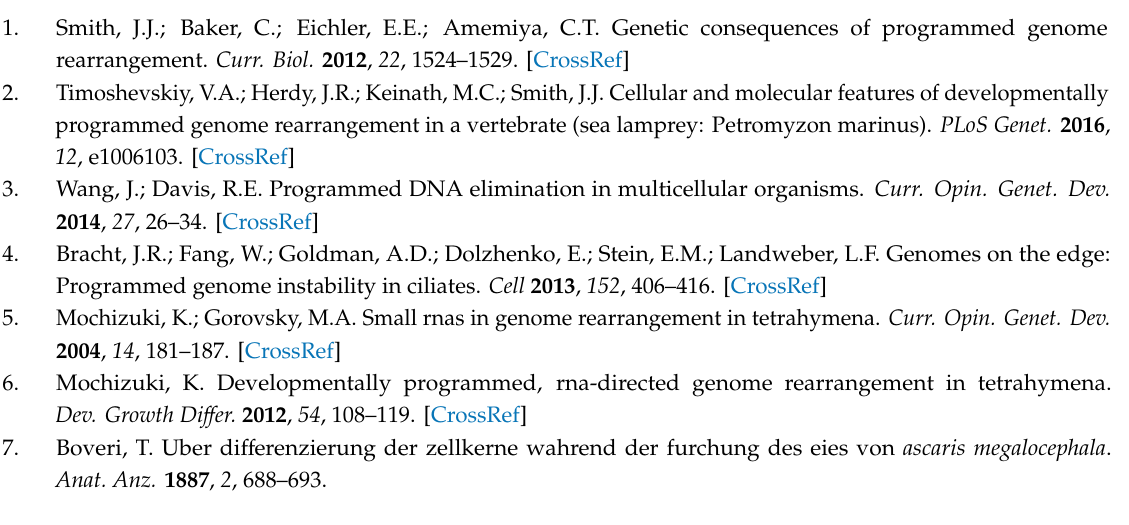
Figure S1. C 0 t CGH on anaphase chromosomes of the sea lamprey embryos undergoing germline chromosome elimination. Figure S2. FISH of centromeric and telomeric probes on somatic spreads and lagging anaphases. Figure S3: Validation of germline enriched repeats via PCR. Figure S4. FISH of a probe generated from laser capture of lagging chromatin and Germ1-repeat on meiotic (germline) and mitotic (somatic) chromosomes. Figure S5. Meiotic chained multivalents in the sea lamprey spermatid metaphase spreads. Figure S6. Telomere dynamics in lagging anaphases. Table S1: Enrichment scores and genomic span of the repetitive elements. Table S2. Clustering of high-copy elements with enrichment scores exceeding 5 and estimated span exceeding 40 kb. Table S3. Repeats GERM2-7: enrichment scores, estimates of the total genomic span, sequence structure and PCR primers used for validation and generation of FISH probes. Table S4. Repeats PMrep1-3: enrichment scores, estimates of the total genomic span, sequence structure and PCR primers used for validation and generation of FISH